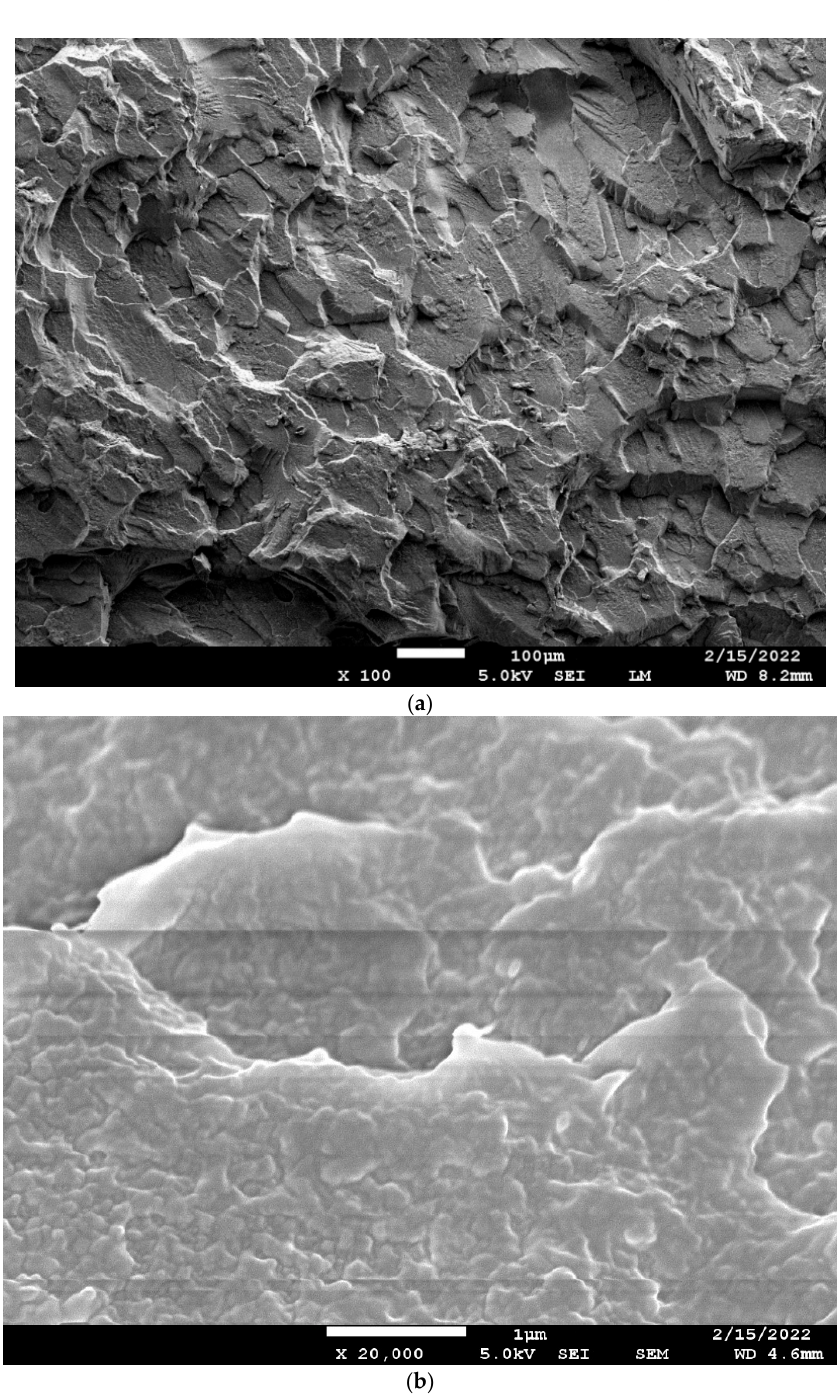
Figure 14. ( a ) Low magnification picture of cryo-fracture surface of 60/40 PBT/PET bar. The white size bar = 100 μ m. ( b ) High magnification of the cryo-fracture surface of 60/40 PBT/PET bar shows the interpenetrating co-continuous domains of PET and PBT. The white size bar = 1 μ m. Unlike most other polymer blends, the domain dimensions are sub-micron.